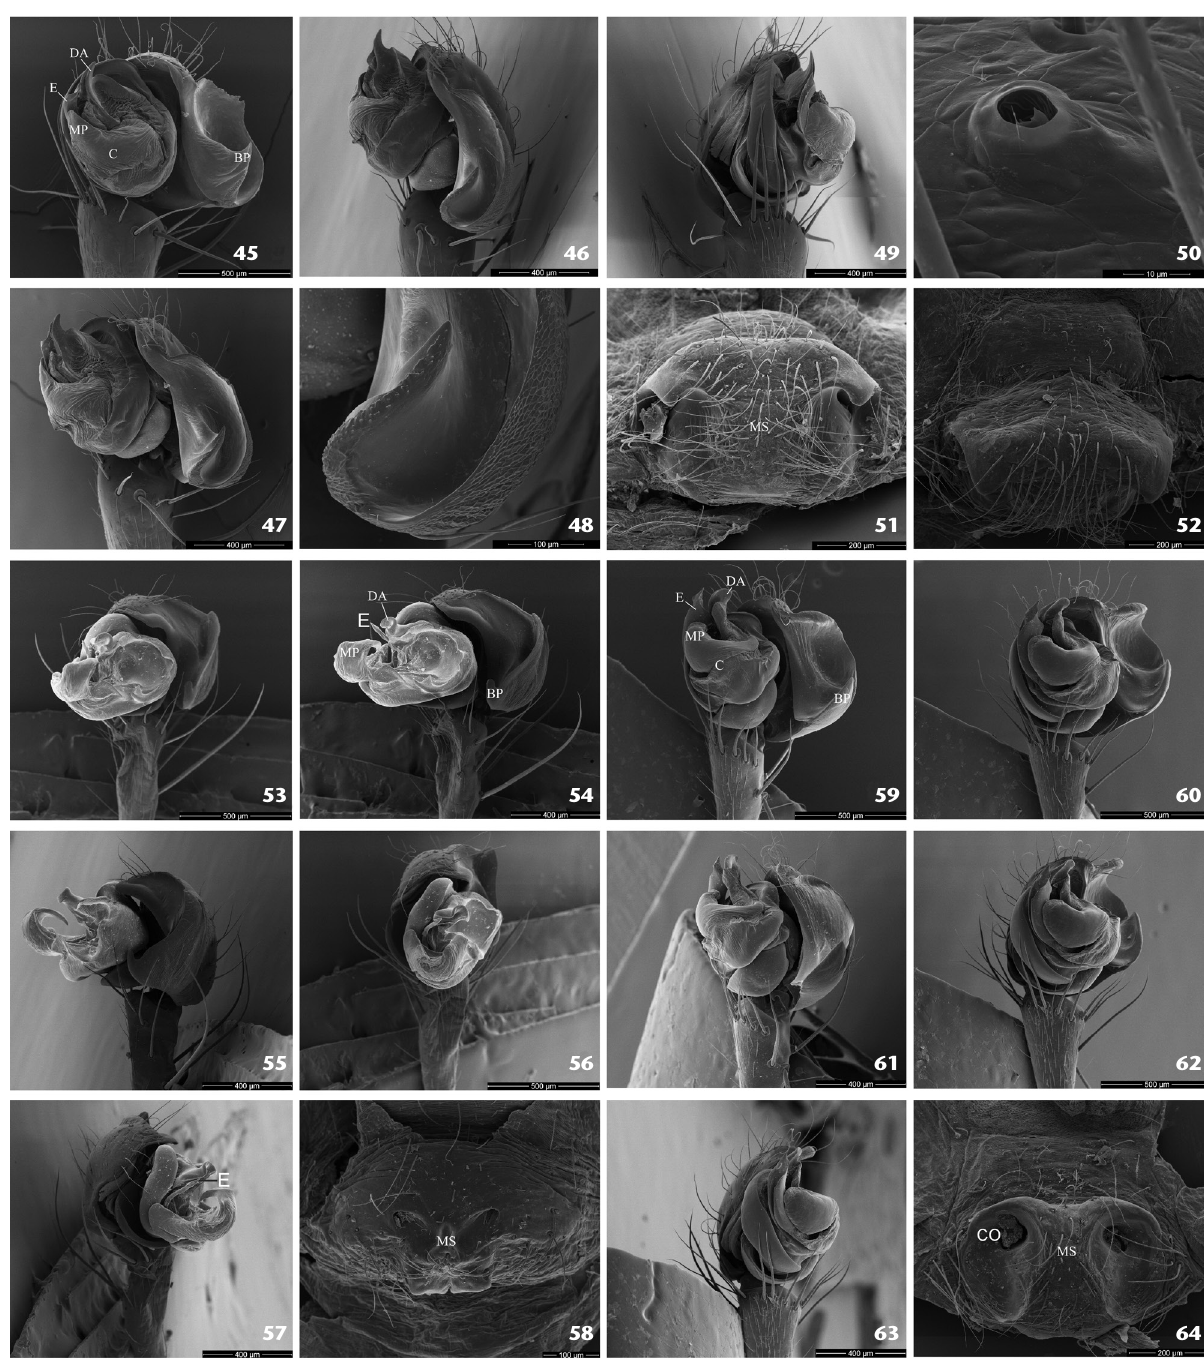
14Figures 45-64. (45-48) Gelanor altithorax : (46-49) male palp: (45) ventral, (46) retrolateral, (47) retroventral, (48) paracymbium, detail. (49-52) Gelanor altithorax : (49, 50) male palp: (49) prolateral, (50) tarsal organ, cymbium; (51-52) epigynum: (51) ventral, (52) anteri- or. (53-58) Gelanor consequus : (53-57) male palp: (53) ventral, (54) retroventral, (55) retrolateral, (56) proventral, (57) prolateral; (58) epigynum: ventral. (59-64) Gelanor juruti : (59-63) male palp: (59) ventral, (60) ventral, (61) retroventral, (62) proventral, (63) prolateral; (64) epigynum: